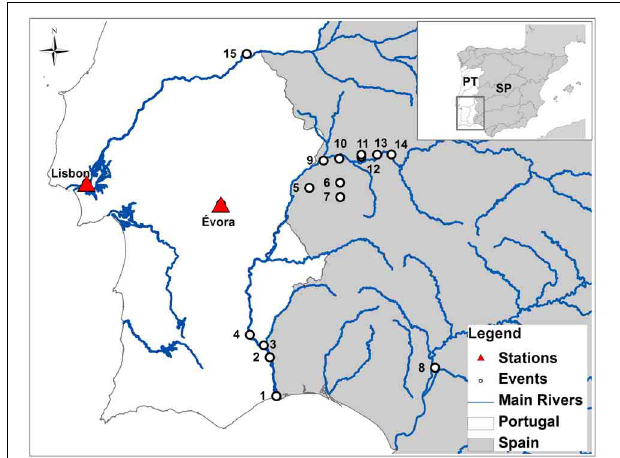
FIGURE 2 | Location of some of the most affected places by the flood of 1876 mentioned by several newspapers. 1- Vila Real de St António, 2-